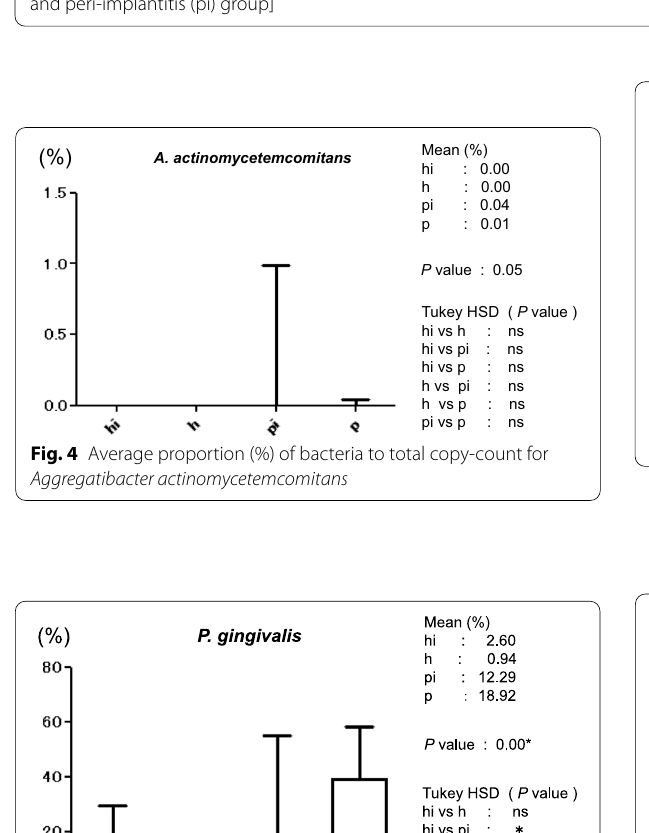
Fig. 3 Average copy-count number (10 8 copies/ml) of the four study groups [healthy (h) group, periodontitis (p) group, healthy implant (hi) group, and peri-implantitis (pi) group]